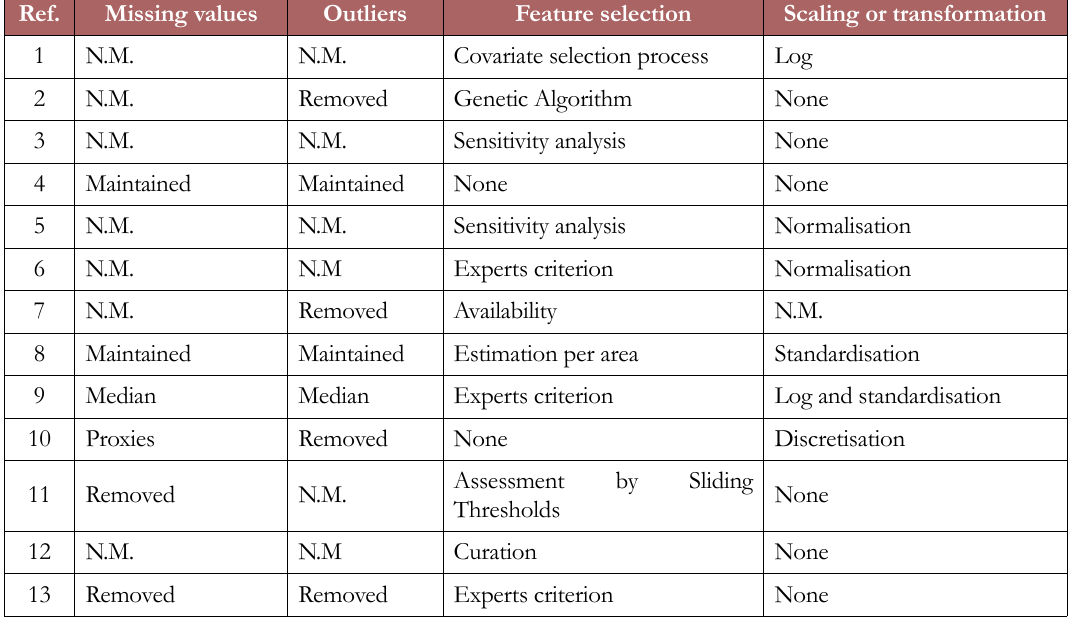
Table 2. Techniques applied in the data processing stage of each